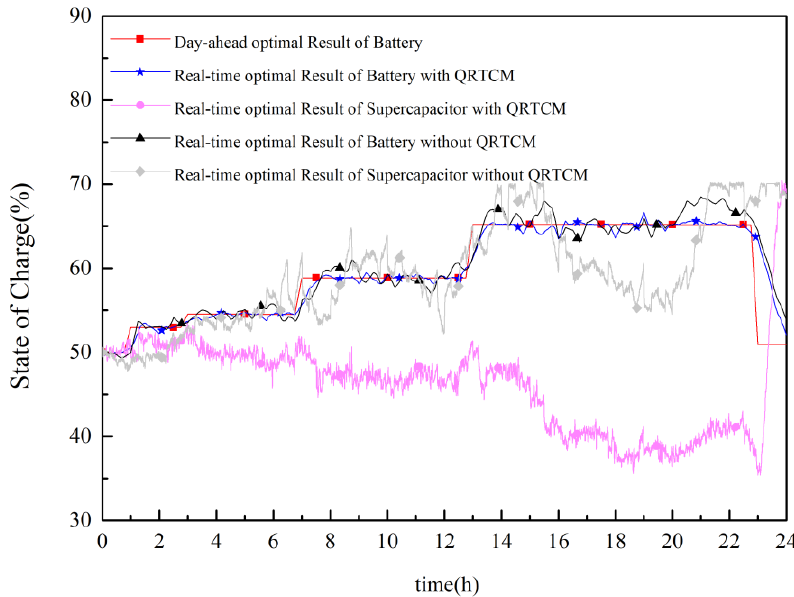
Figure 10. SOC comparison between situations whether using quasi-real-time model.